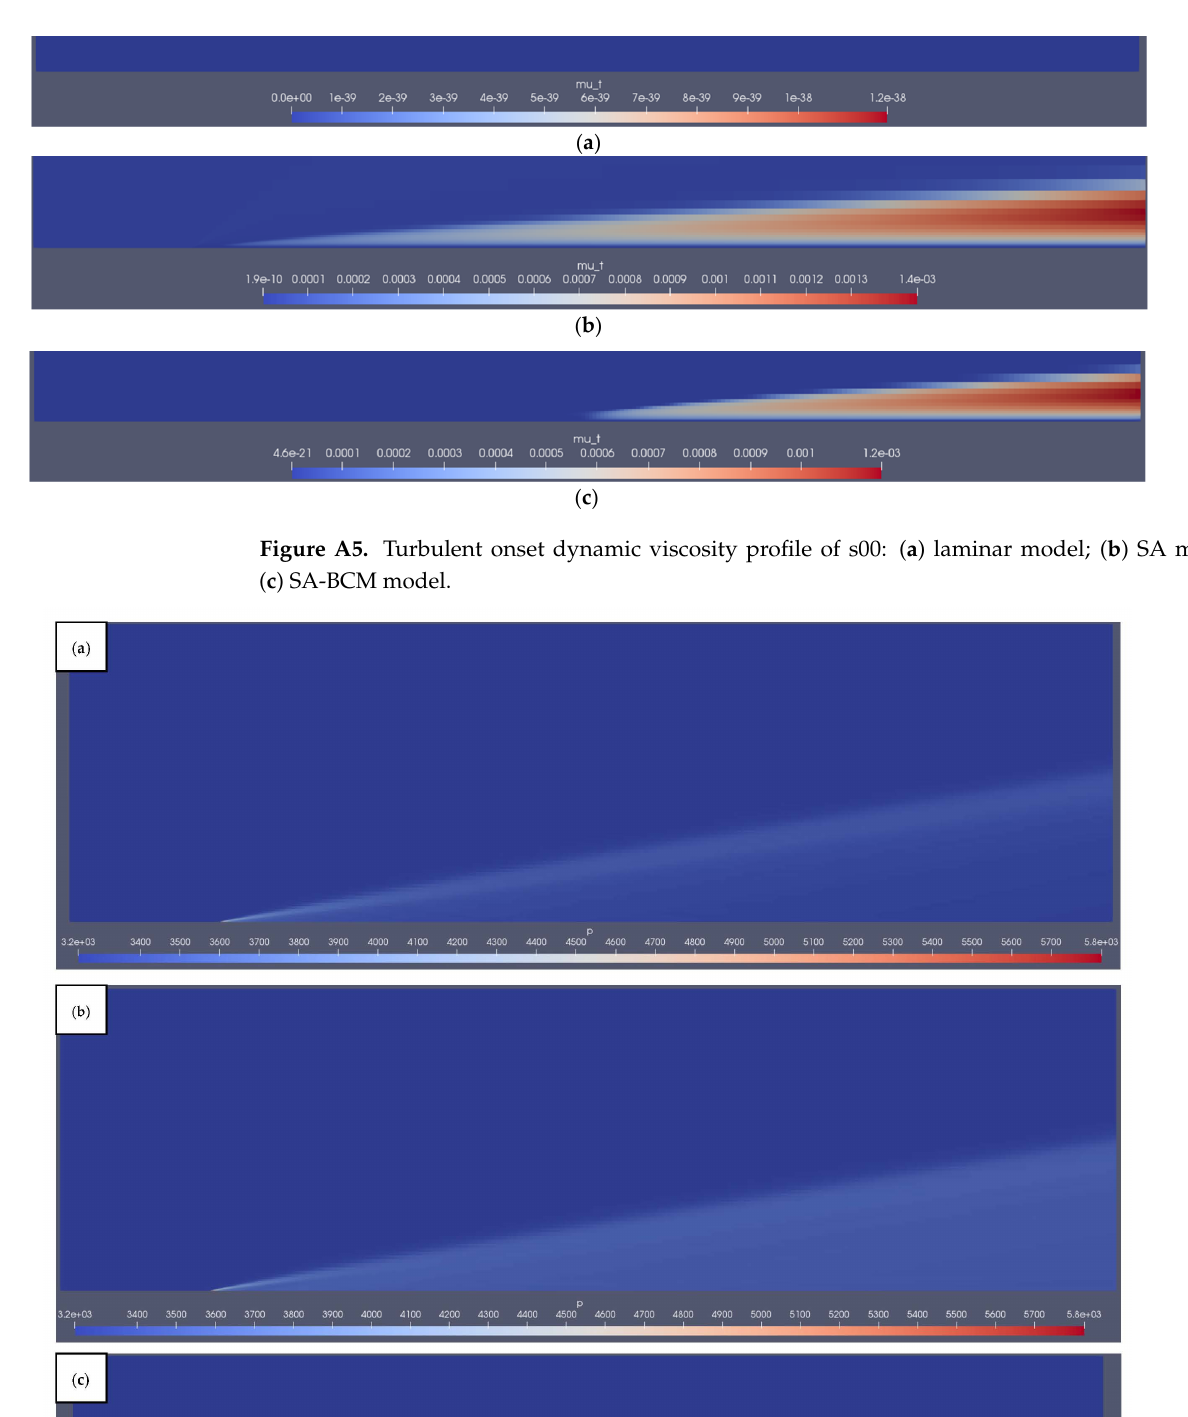
Figure A4. Dynamic viscosity profile of s00: ( a ) laminar model; ( b ) SA model; ( c ) SA-BCM model.